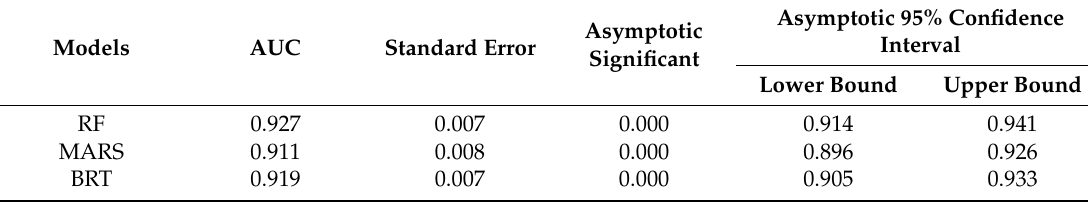
Table 6. Area under the curve (AUC) values of RF, MARS, and BRT data mining